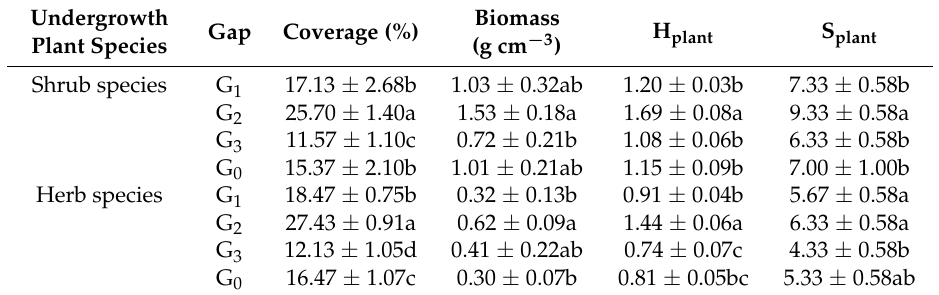
Table 1. The plant characteristics from four treatments. Values are the mean ± standard deviation (n = 3).